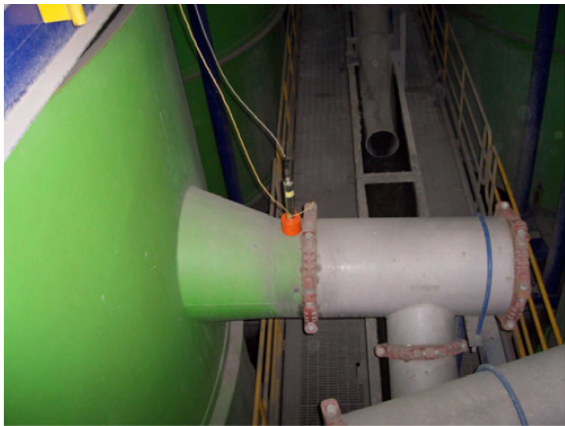
Figure 8. Normalized activity response and adjusted models for coarse solid tracer in cell tailings.